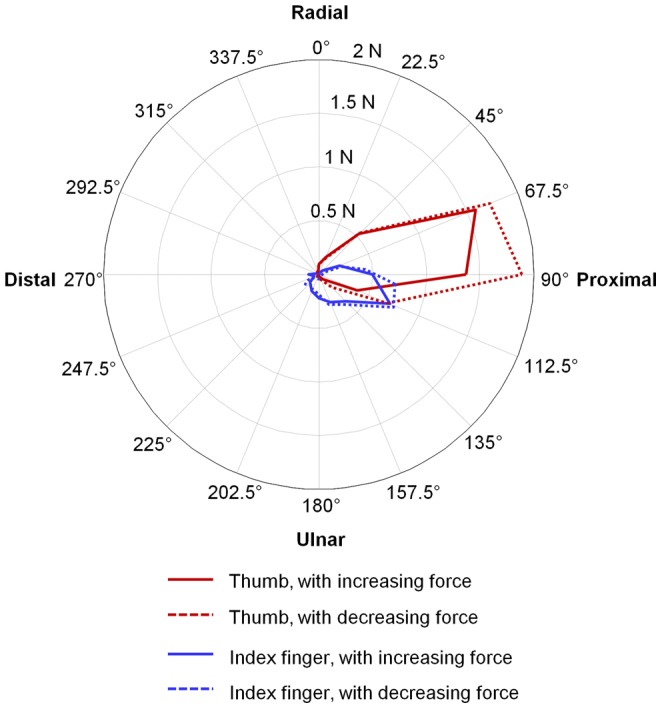
Shear force tuning curves for the thumb and index finger.